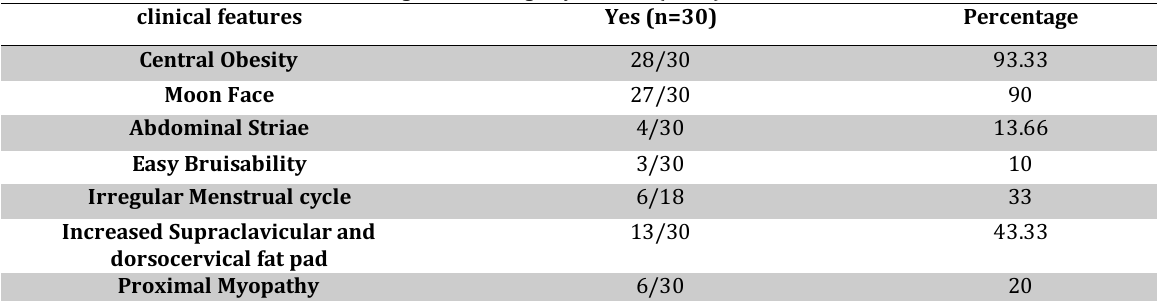
Table-3. Clinical manifestation’s in iatrogenic Cushing’s syndrome (n=30) clinical features